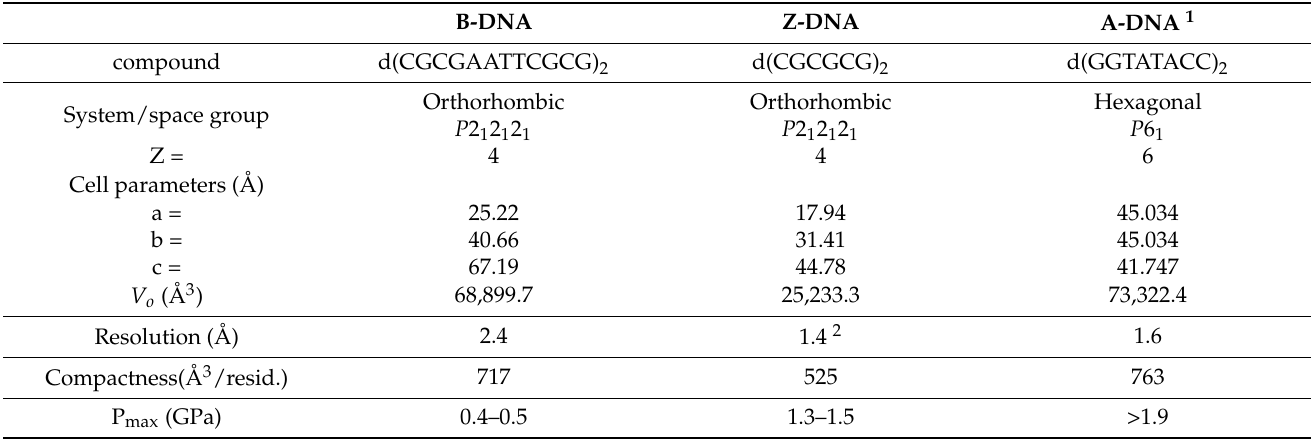
Table 3. DNA crystal characteristics at ambient